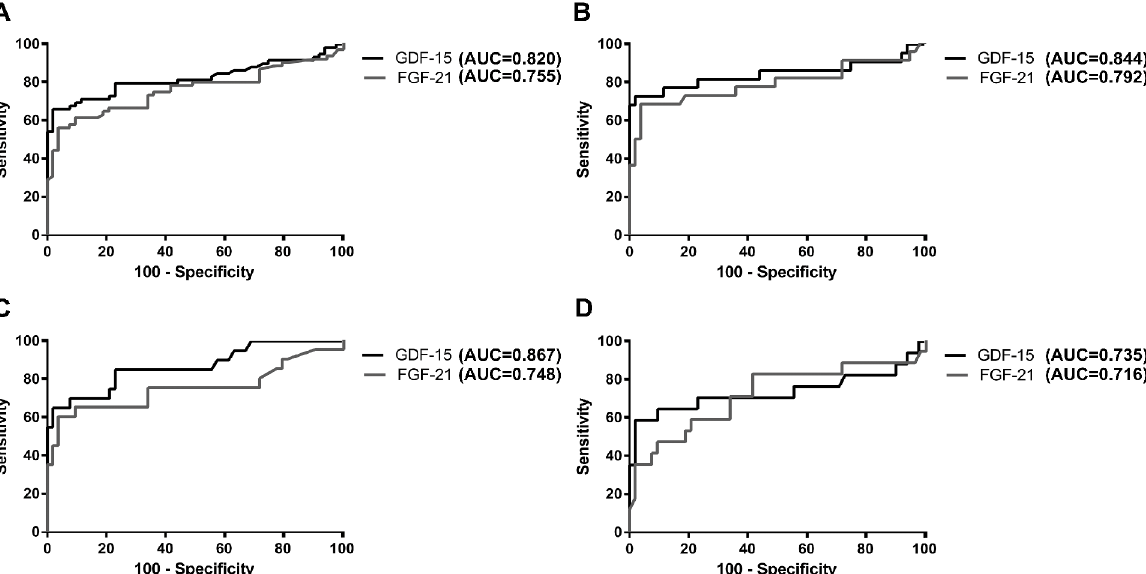
Fig 3. Receiving Operating Curve. analysis for GDF-15 and FGF-21 considering patients in groups 1, 2 and 3 together (A) or patients group 1(B), group 2 (C) and group 3(D) separately.